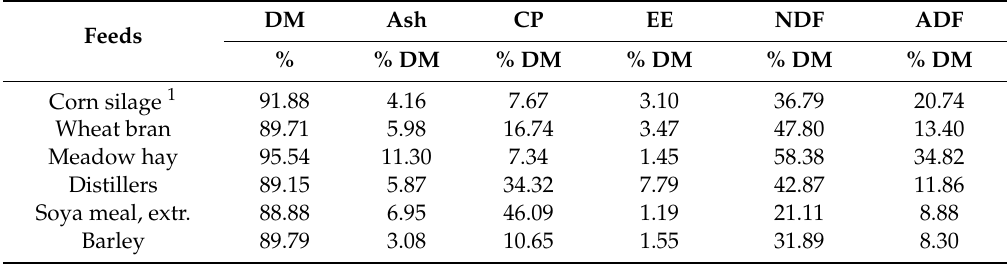
Table 1. Chemical composition of feeds used as substrates in the in vitro tests. DM Ash CP Feeds